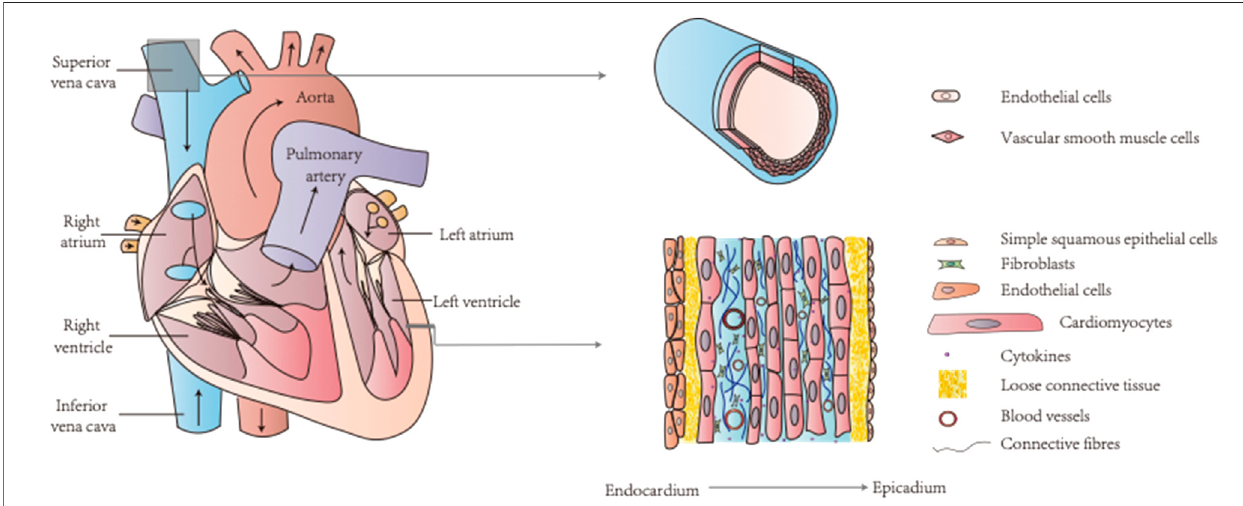
FIGURE 4 | The heart and blood vessels are two key components of the circulatory system containing various types of cells. TCM can target calcium signaling in endothelial cells, vascular smooth muscle cells, and cardiomyocytes for CVDs treatment.